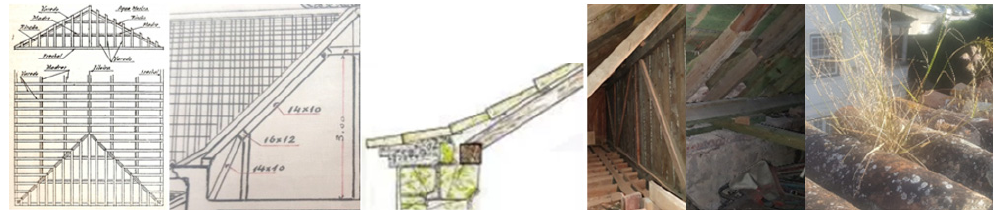
Figure 28. Drawings and pictures of the roof.